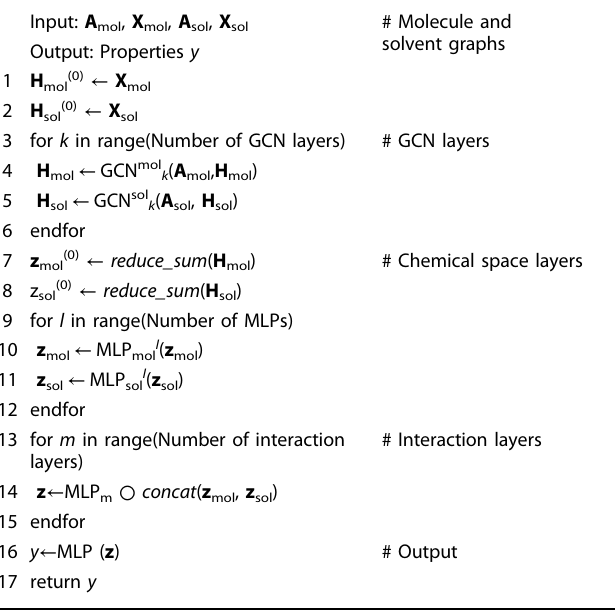
Algorithm 1 . Deep learning model algorithm